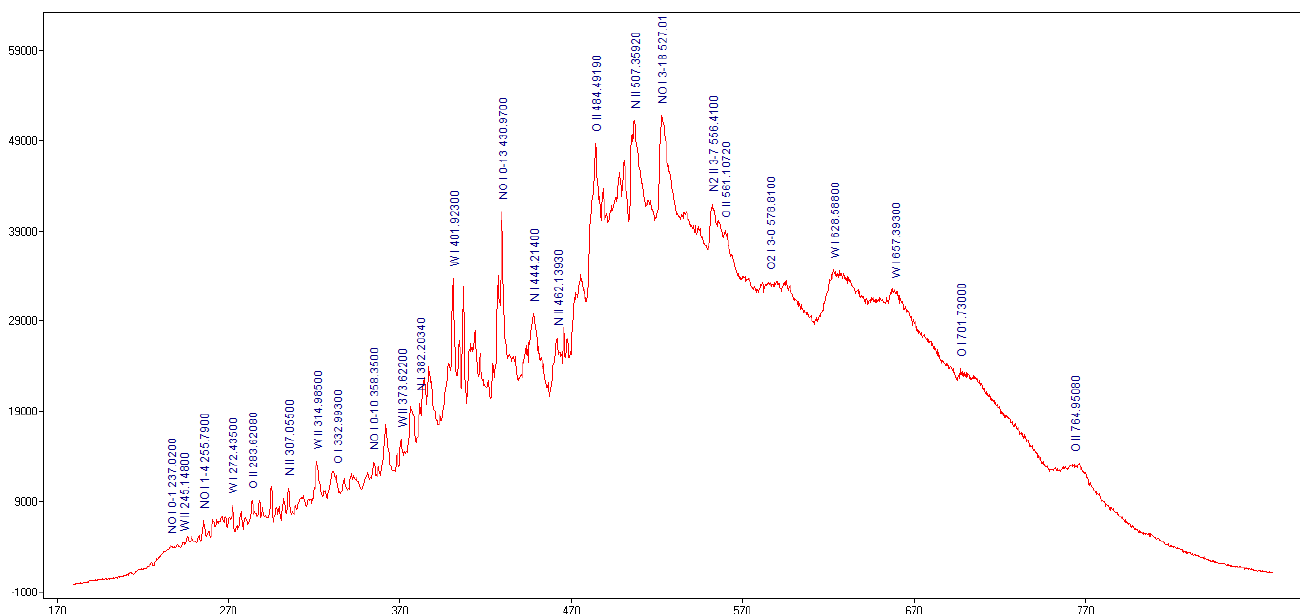
Figure 4. The optical emission spectrum of the generated plasma from a 0.5 mm W wire in air at atmospheric pressure. Wavelength (nm).